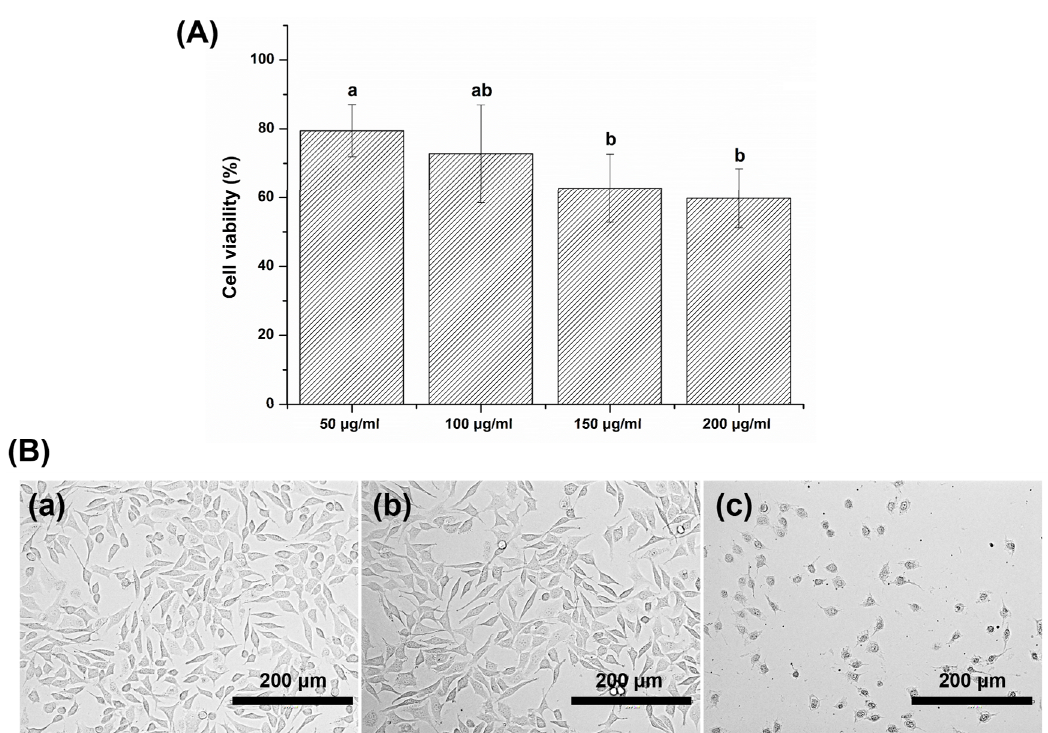
Figure 5. ( A ) Percentage viability of L929 cells exposed to different concentrations of the Glycyrrhiza uralensis extract in the MTT assay. The same lowercase letters show no significant difference in cell viability (%) between the experimental groups ( p > 0.05). ( B ( a )) L929 cells exposed to negative control, ( B ( b )) L929 cells exposed to G. uralensis extract at a concentration of 50 µ g / mL, and ( B ( c )) L929 cells exposed to G. uralensis extract at a concentration of 200 µ g / mL for 24